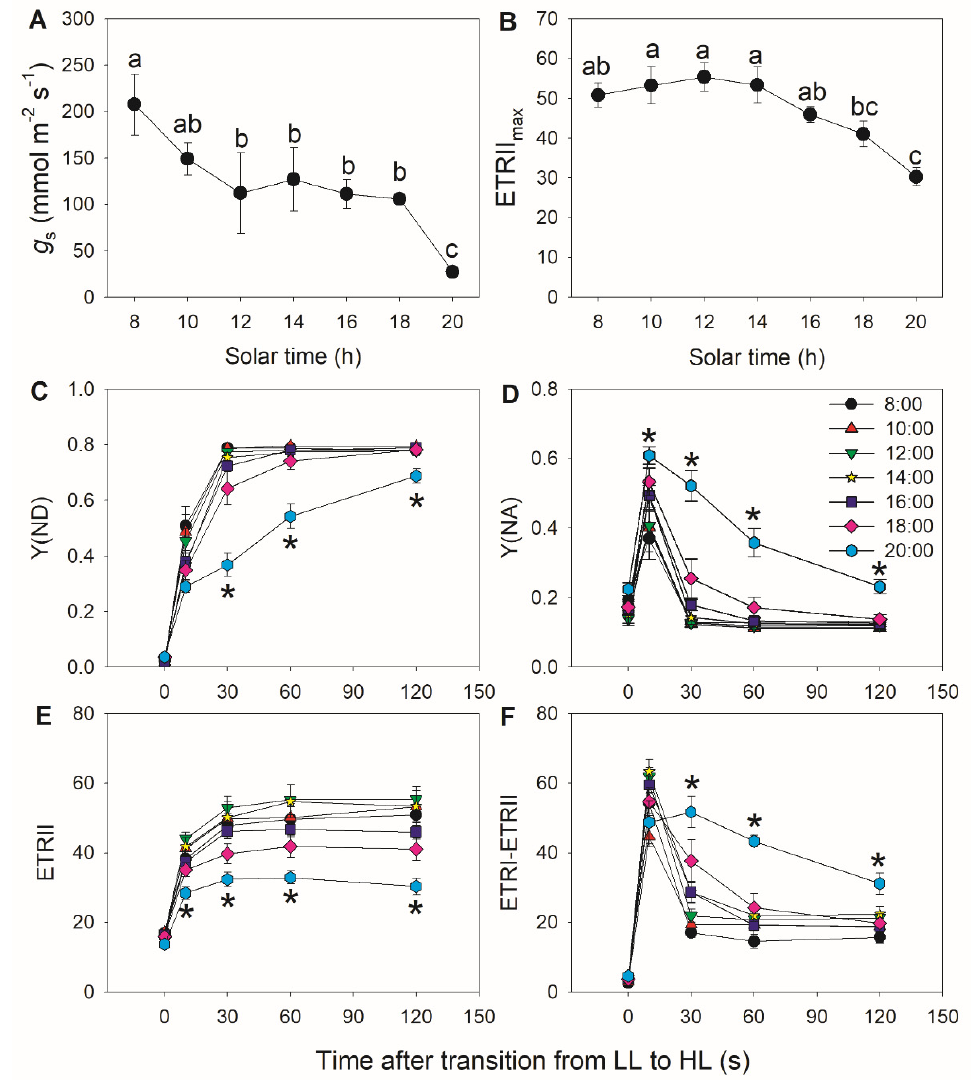
Figure 4. Diurnal variation in photosynthetic performance of M. alba leaves: ( A ) stomatal conductance ( g s ). ( B ) Maximum electron transport rate through PSII (ETRII max ). ( C – F ) Changes in photosynthetic parameters during fluctuating light alternating between 59 and 1455 µ mol photons m − 2 s − 1 . ( C ) Y(ND), quantum yield of PSI non-photochemical energy dissipation due to donor side limitation. ( D ) Y(NA), quantum yield of PSI non-photochemical energy dissipation due to acceptor side limitation. ( E ) ETRI, electron transport rate through PSI. ( F ) Estimated CEF performance, calculated as ETRI–ETRII. In ( A ) and ( B ), different letters indicate significant differences. In C – F , asterisk indicates a significant difference between 20:00 and the other times. Data are shown as mean ± SE ( n = 6).